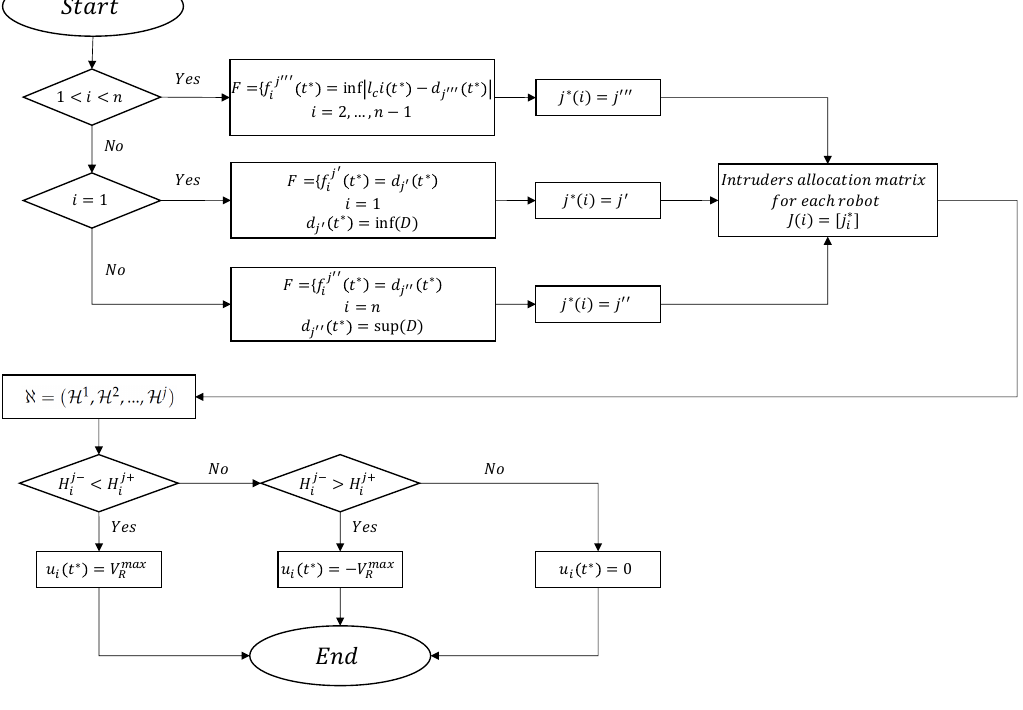
Figure 3. Decision making on multiple intruder